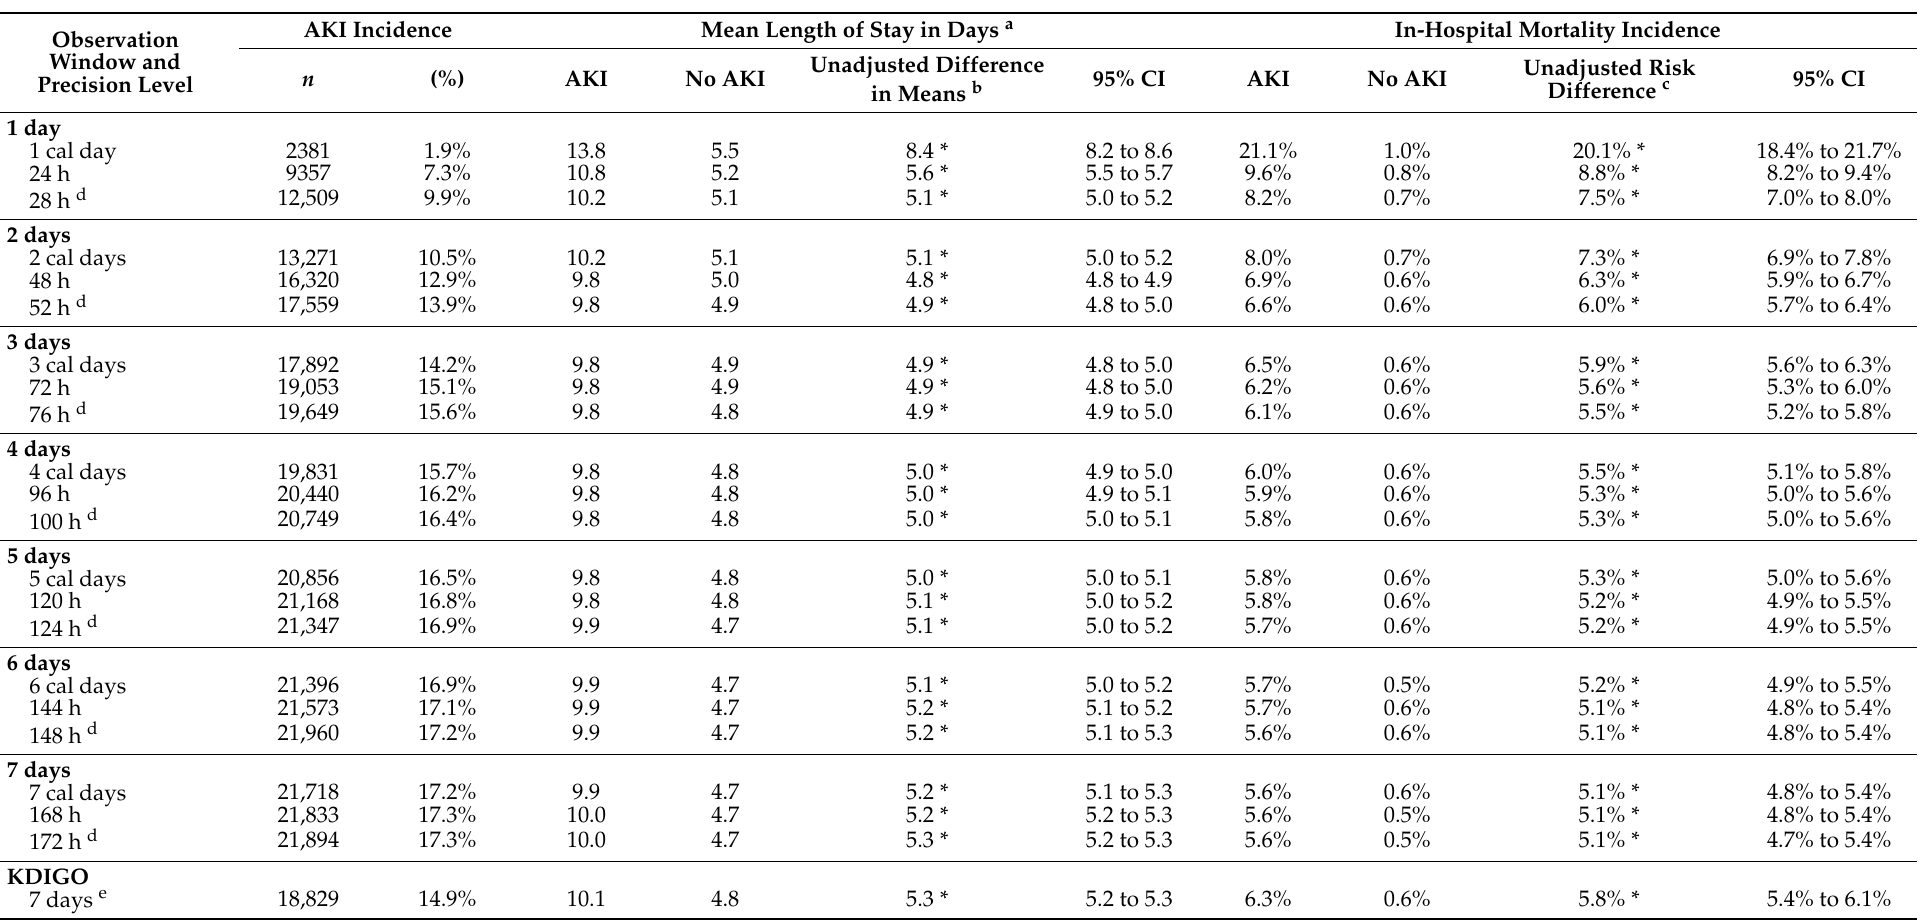
Table 2. Incidence of acute kidney injury based on observation window and precision level with the outcomes length of stay and in-hospital mortality ( n = 126,367). Observation Window and Precision